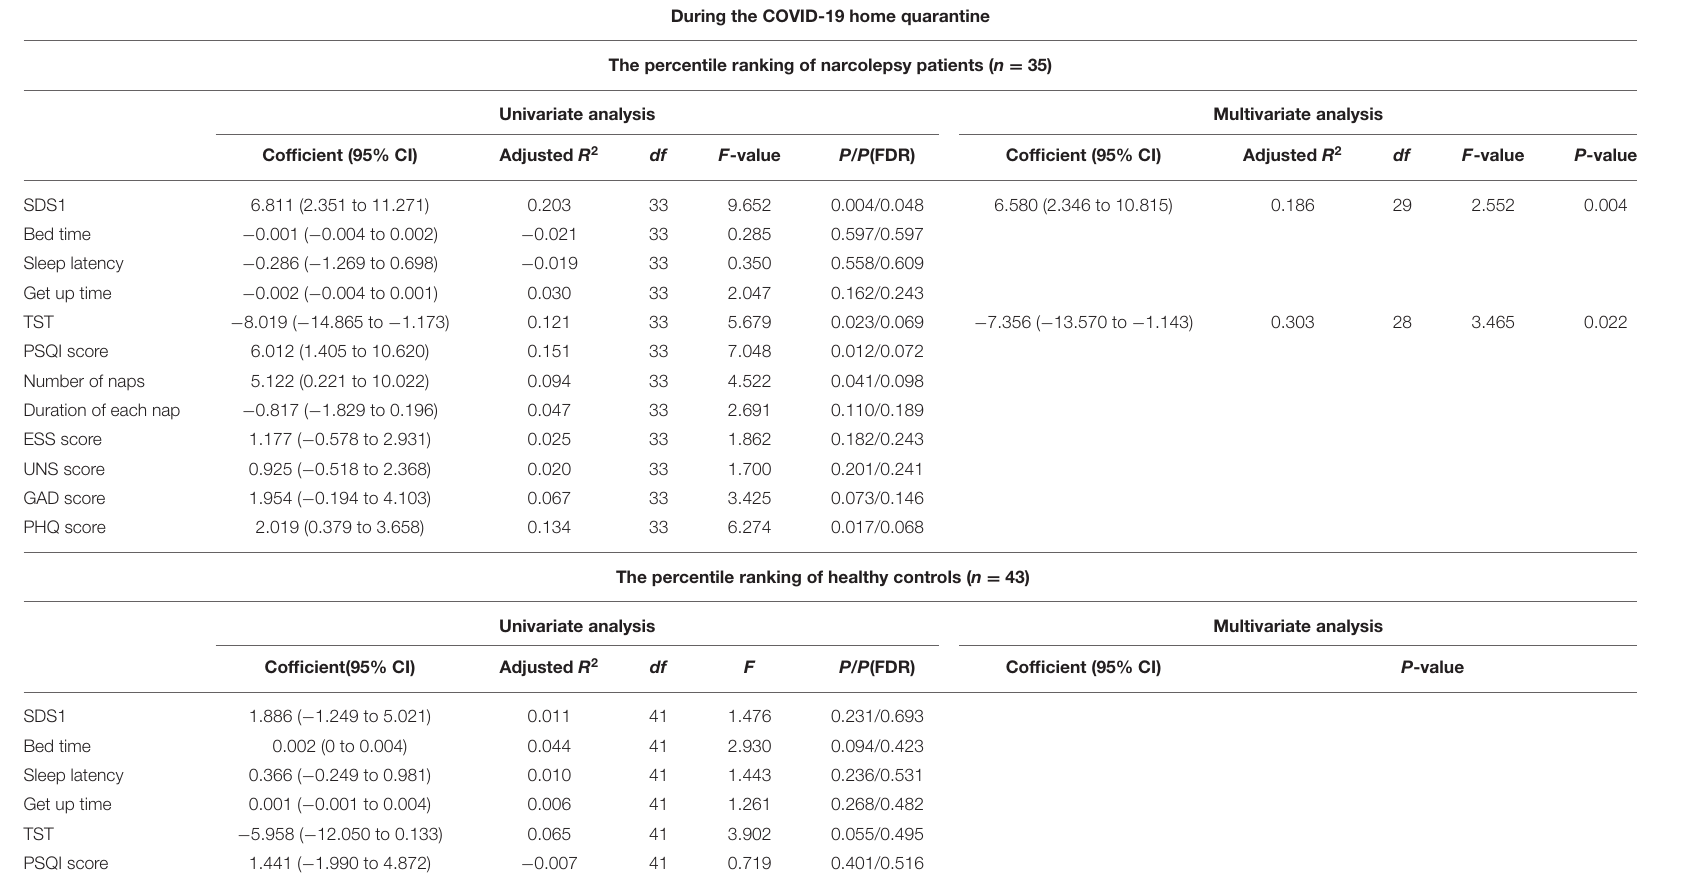
TABLE 5 | Univariate and multiple linear stepwise regression analysis were used to determine the percentile ranking and changes in sleep patterns in the patients and healthy controls respectively. During the COVID-19 home quarantine The percentile ranking of narcolepsy patients ( n =